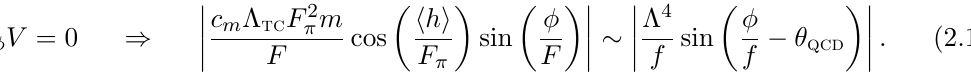
(cid:1) (cid:30) f from its initial stopping j j (cid:24) h will be negligible. h i